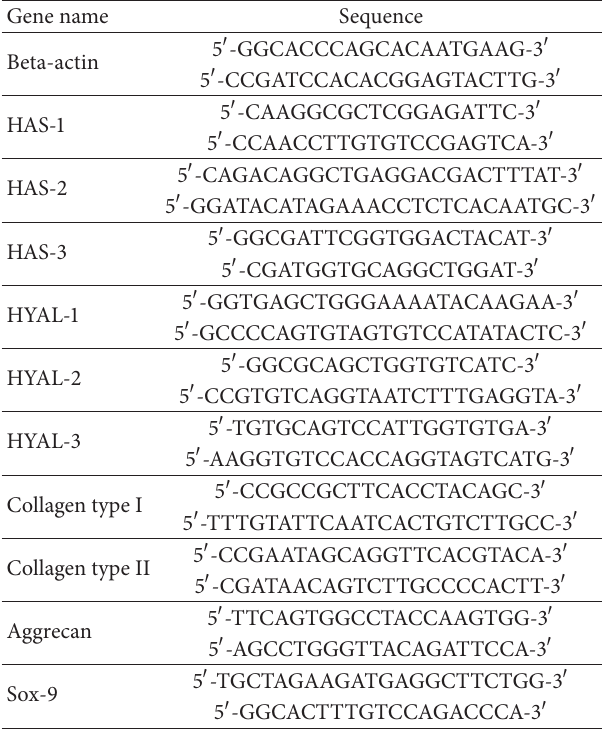
Table 1: Sequence of